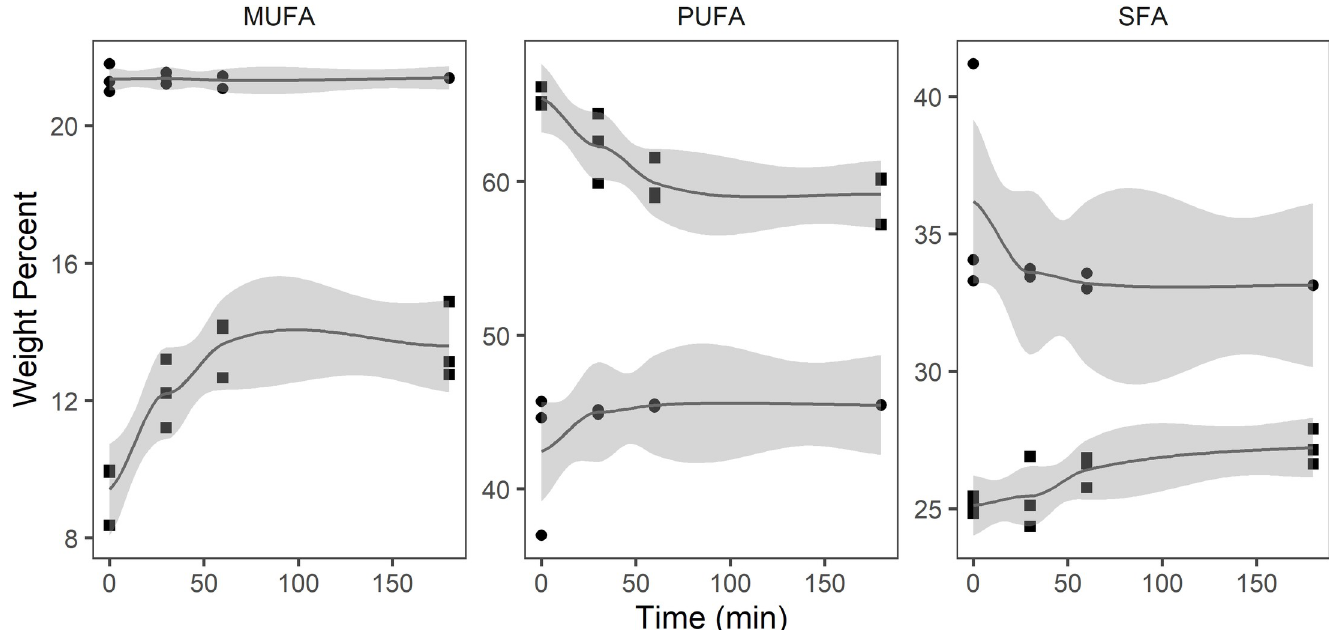
Fig 2. Monounsaturated fatty acids (MUFA), polyunsaturated fatty acids (PUFA), and saturated fatty acids (SFA) (weight percent) in free fatty acid (square) and neutral lipid (circle) fraction of Calanus 1 oil (n = 3) during in vitro digestion.